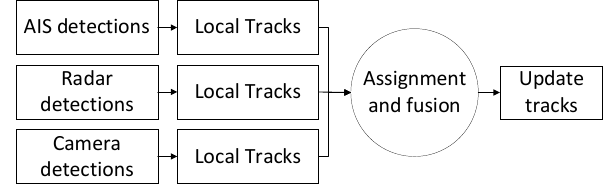
Fig. 2. Structure of track-level